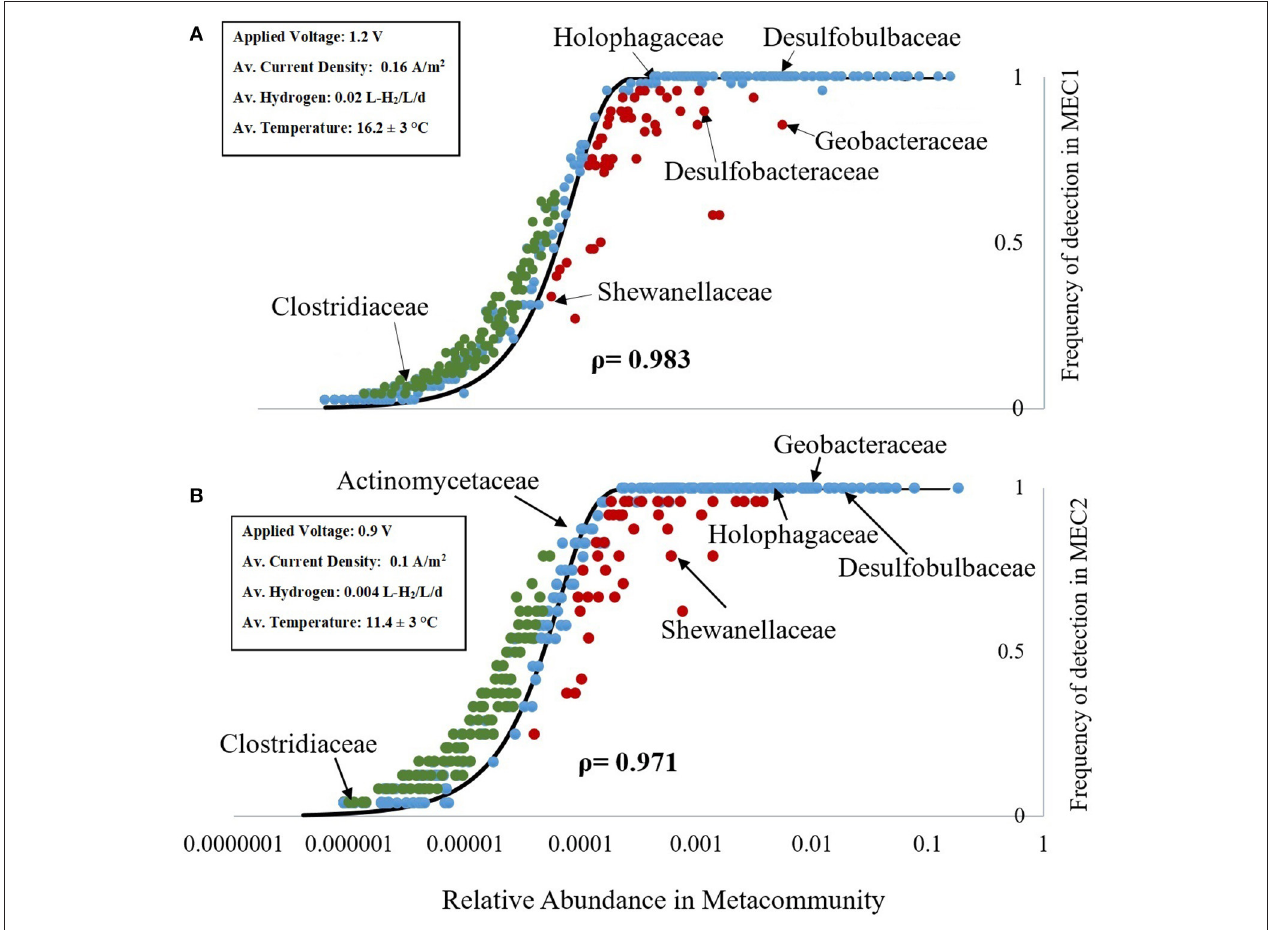
FIGURE 1 | Mean relative abundance of taxa in the metacommunity vs. the frequency of detection in the anodes of MEC1 (A) and MEC2 (B) . Blue dots represent taxa whose observed frequency of detection in the MEC samples aligns with the NCMs prediction (black line), based on their relative abundance in the metacommunity. Taxa observed more (or less) frequently in the MEC than would be predicted, based on their relative abundance in the metacommunity, are shown in green (and red), respectively. The N T m values were 18,091 for MEC1 (A) , and 18,607 for MEC2 (B) . Key families of anaerobic and electrogenic bacteria are labeled. Key operating conditions and performance data are highlighted in the inset